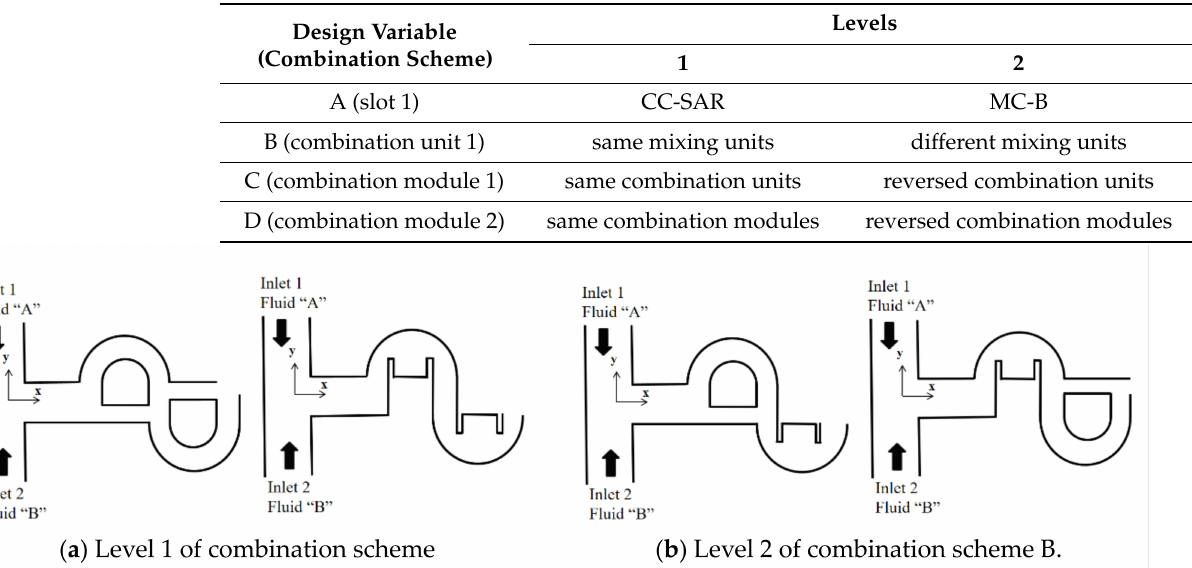
Table 1. Four combination schemes (A, B, C, and D) and their levels.